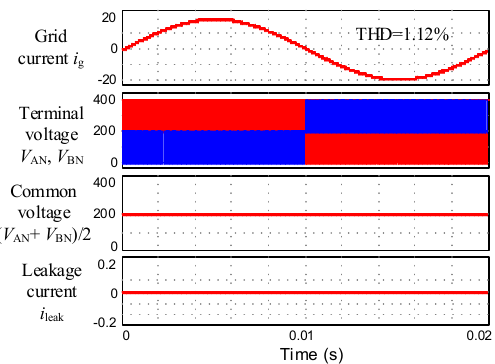
Figure 28. Waveforms of grid current, terminal voltage, CM voltage, and leakage current.